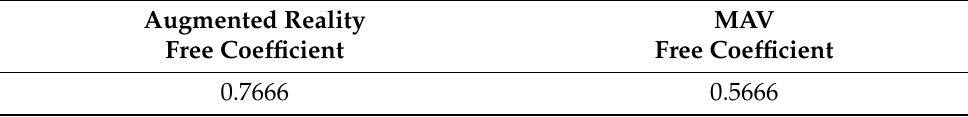
Table 9. Free coefficient in real